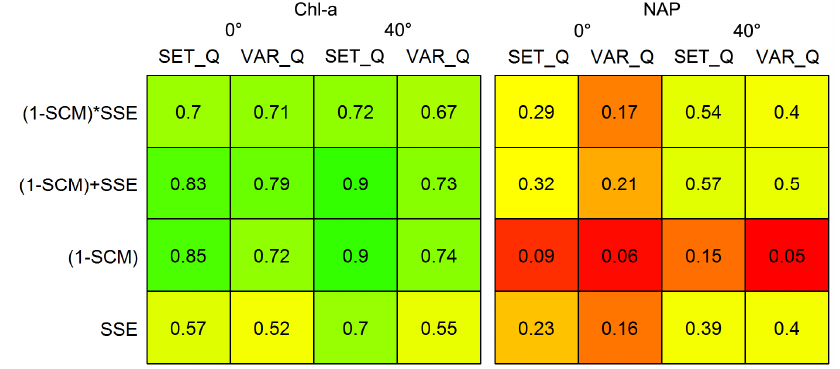
Figure 9. Objective functions and Q evaluated for both viewing angles after full model parameterization. The values reported in the boxes R 2 calculated between modelled and measured constituent concentrations.